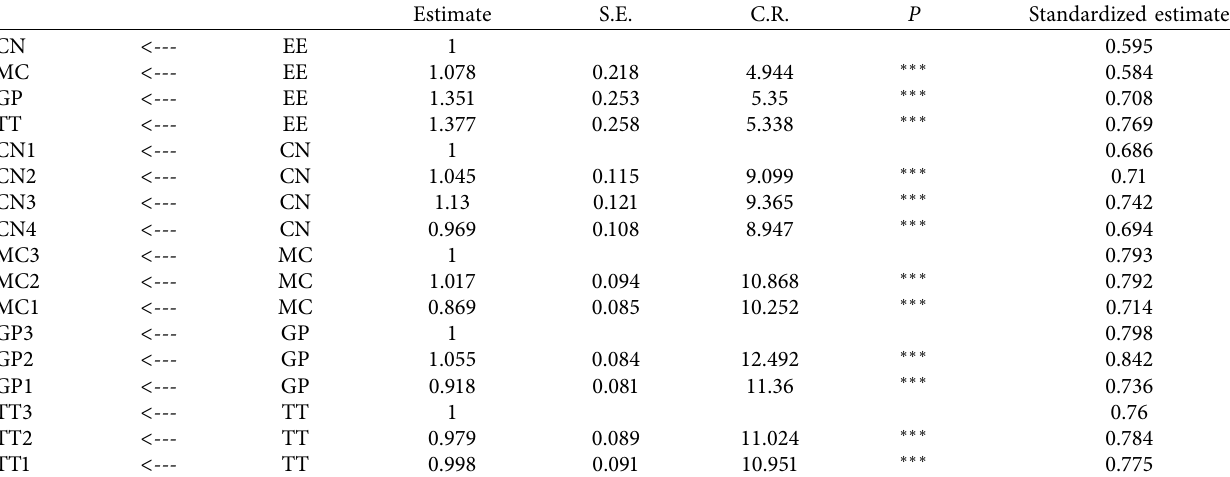
Table 5: Second-order factor convergence validity coefficient of external